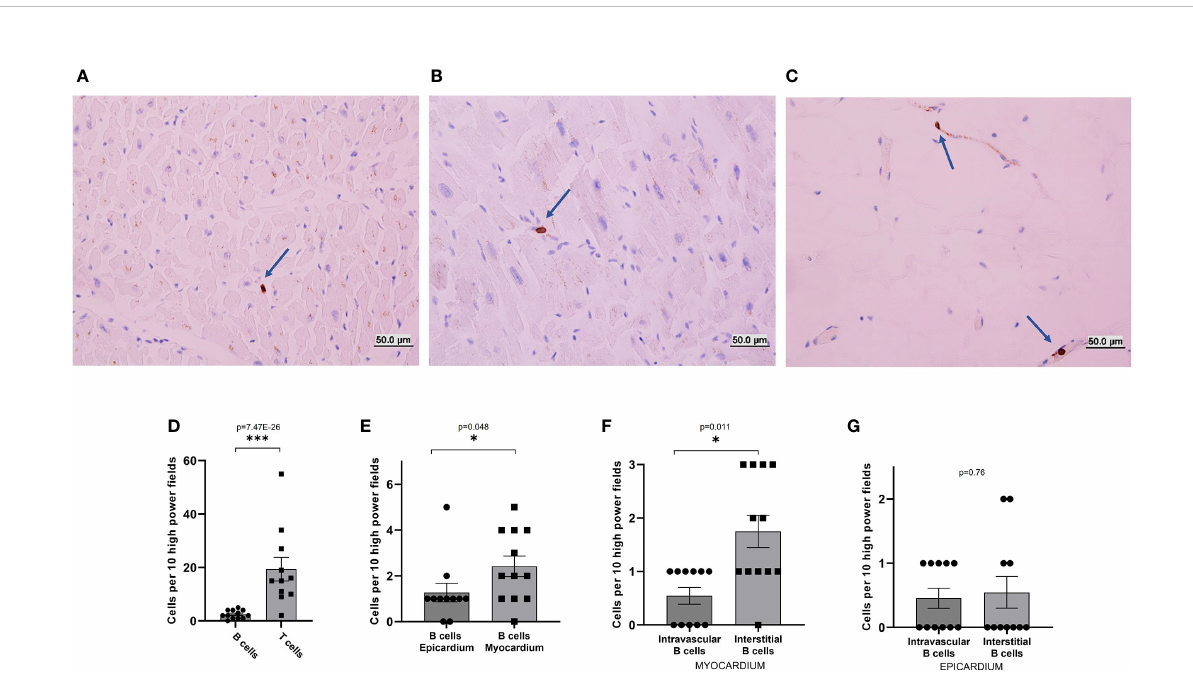
FIGURE 1 Immunohistochemical analysis of B-cells in human heart sections. (A – C) Representative images from CD20 immunohistochemical stains of histological sections of hearts collected post-mortem from decedents without known cardiac pathology. B-cells were found in the interstitial/ extravascular space (A) , in the intravascular space (B) , and the epicardium (C) . Blue arrows mark the location of B-cells. (D – F) quanti fi cation of the number of cells per 10 high power fi elds. (D) The total number of T-cells identi fi ed in the myocardial histological sections was about eight times higher than the total number of B-cells (p-value=7.47E-26). (E) The total number of B-cells per high power fi eld observed in the epicardium was similar to the total number of cells per high power fi eld observed in the myocardium (p-value=0.048). (F) In the myocardium, B-cells were unevenly distributed between interstitial space and intravascular space, with a preference for the interstitium (p-value=0.011). (G) In the epicardium, B-cells were evenly distributed between interstitial space and intravascular space, (p-value=0.76). p-values were calculated with a Poisson test. The bars represent average and the error bars represent the SEM. *p-value<0.05;